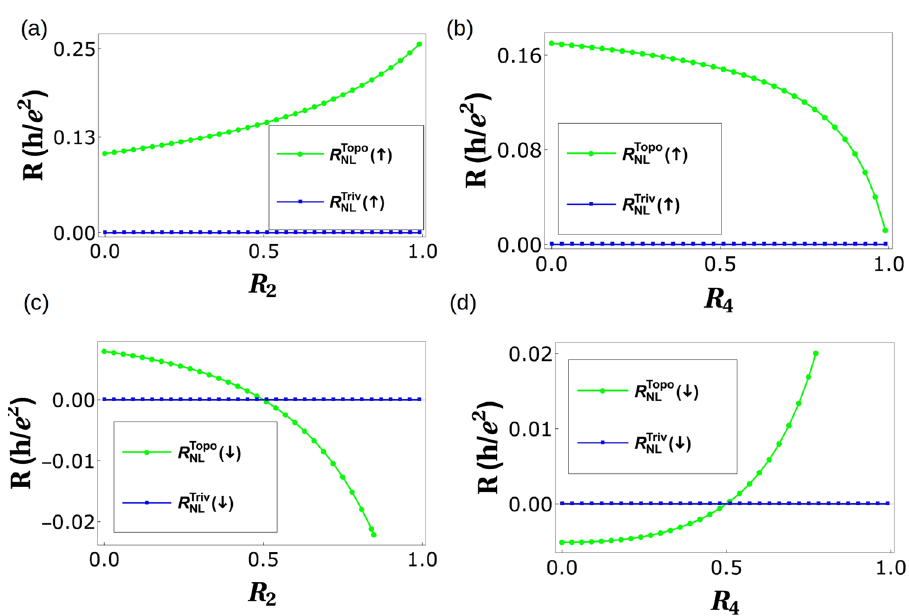
Figure 6. Non-local resistances ( R NL ( ↑ )) for magnetization direction ( ↑ ) and ( R NL ( ↓ )) for magnetization direction ( ↓ ) in presence of both disorder as well as inelastic scattering. ( a ) R NL ( ↑ ) for chiral(topological) QAH edge mode with quasi-helical QSH edge modes and chiral (trivial) QAH edge mode with quasi-helical QSH edge modes for parameters R 4 = 0.5, f = f 0 = 0.5, ( b ) R NL ( ↑ ) for chiral(topological) QAH edge mode with quasi-helical QSH edge modes and chiral (trivial) QAH edge mode with quasi-helical QSH edge modes for parameters R 2 = 0.5, f = f 0 = 0.5. ( c ) R NL ( ↓ ) for chiral(trivial) QAH edge mode with quasi-helical QSH edge modes and chiral(trivial) QAH edge mode with quasi-helical QSH edge modes for parameters R 4 = 0.5, f = f 0 = 0.5, ( d ) R NL ( ↓ ) for chiral(trivial) QAH edge mode with quasi-helical QSH edge modes and chiral(trivial) QAH edge modes with quasi-helical edge modes for parameters R 2 = 0.5, f = f 0 =